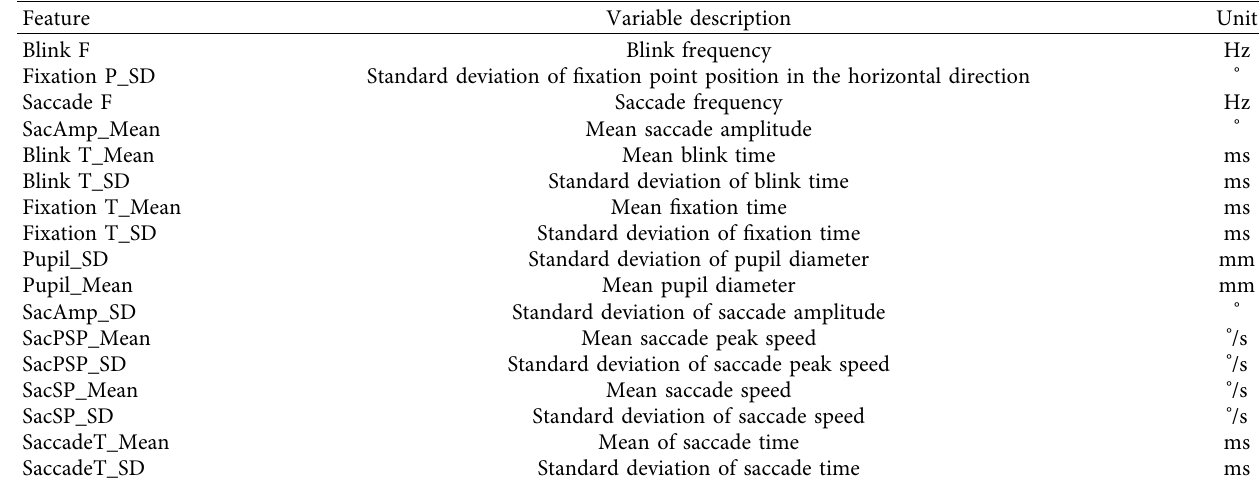
Table 3: Eye movement